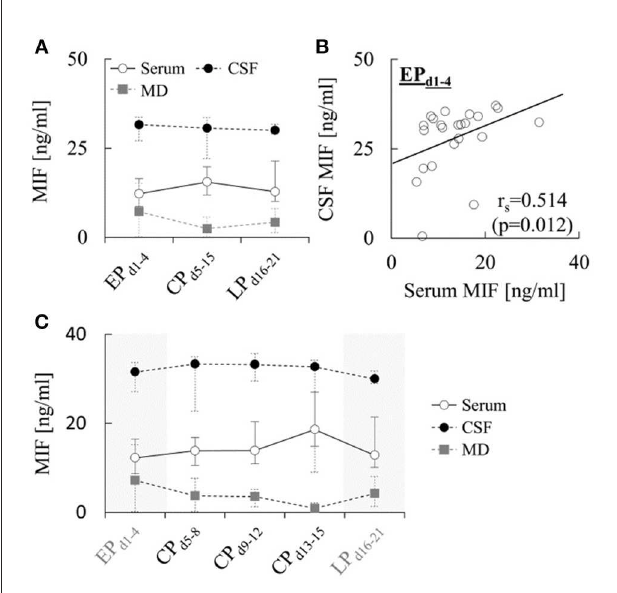
FIGURE1 Concentration of MIF in different compartments after aSAH. (A) Concentration of macrophage migration inhibitory factor (MIF) measured in the indicated compartments during the early (EP d1 − 4 ), critical (CP d5 − 15 ) and late (LP d16 − 21 ) phase after aneurysmal subarachnoid hemorrhage (aSAH). In total, at least one sample for quantification of MIF levels during EP d1 − 4 , CP d5 − 15 and LP d16 − 21 was available from 26, 19 and 26 (serum), 23, 15 and 11 (CSF) and 9, 20 and 8 (MD) patients, respectively (see Supplementary Tables 1–3). Data are shown as median [25th − 75th percentile]. Statistical significance of changes over time was assessed using a repeated-measures ANOVA. (B) Correlation between MIF concentrations in CSF and serum during the early phase. Correlation analysis was performed using the Spearman’s rank correlation coefficient. (C) Same data as in A, but with measurements obtained between days 5 and 15 subdivided into three sub-intervals to illustrate temporal changes during the critical phase. Note that the number of patients for which samples in these sub-intervals were available was accordingly lower ( n = 10–12, 7–10, and 10–16 per sub-interval for serum, CSF and MD, respectively) than the numbers for CP d5 − 15 given in A and Supplementary Tables